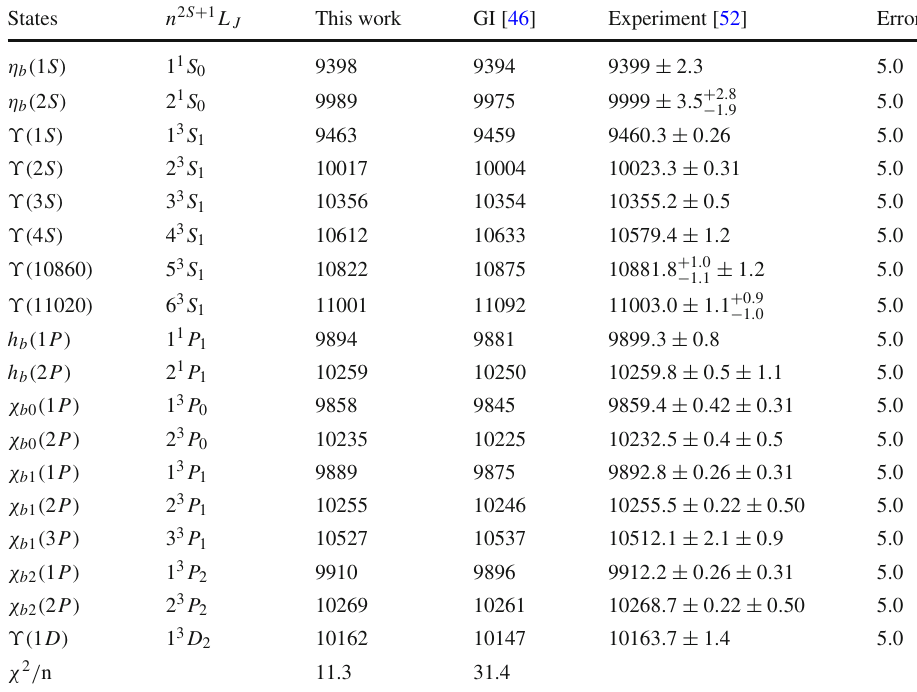
States n 2 S + 1 L